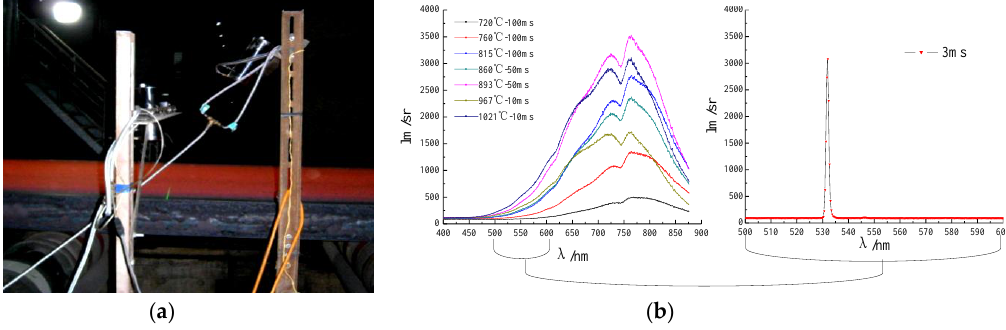
Figure 2. The spectral radiation intensity at different temperatures in slab surface and light intensity distribution of the laser stripe. ( a ) High temperature spectrum measurement; ( b ) Spectral intensity comparison.